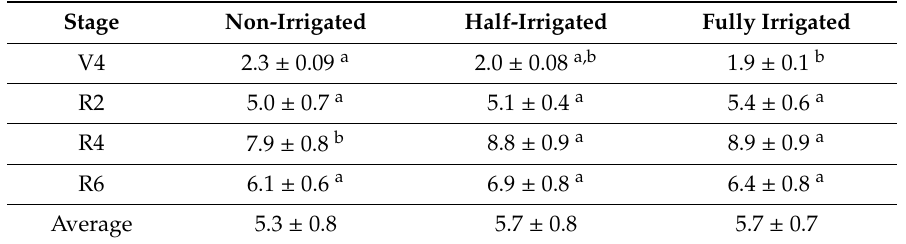
Table 8. The e ff ect of di ff erent irrigation regimes on LAI at di ff erent stages of soybean’s (cv. Pannonia Kincse) life cycle, averaged among 2017, 2018, and 2019 in Debrecen,